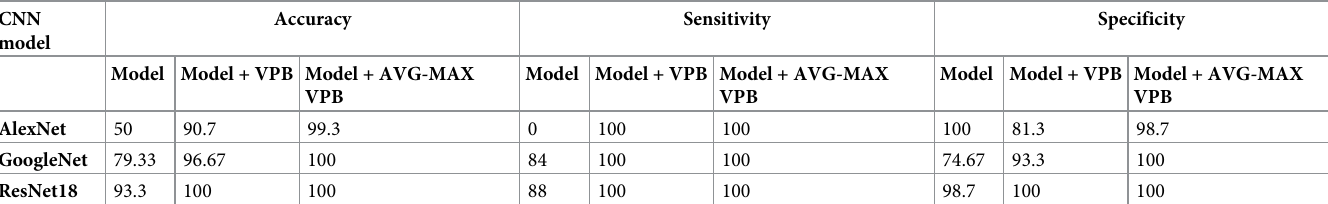
Table 3. Evaluation metrics of the classification process on three CNNs before and after using the VPB and the AVG-MAX VPB. CNN model